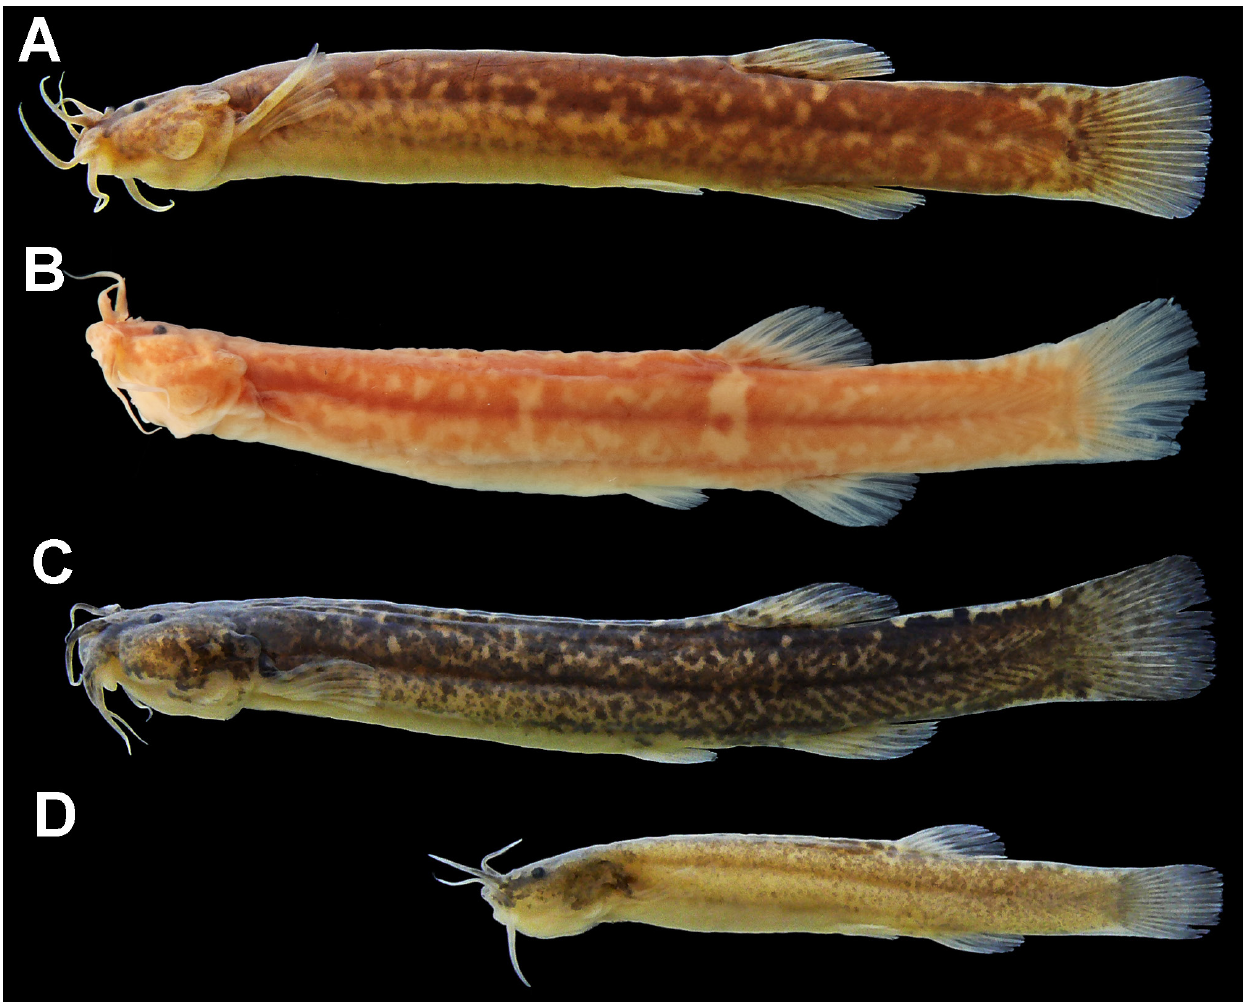
FIGURE 9 | ndividuals representing populations of Cambeva sp. 1 from distinct river drainages. ( A ) Maquiné River basin, UFRGS 22211, 58.6 mm SL, ( B ) Mampituba River basin, MCP 23623, 55.7 mm SL; and ( C , D ) Araranguá River basin, UFRGS 22962, 45.2 and 59.8 mm SL,